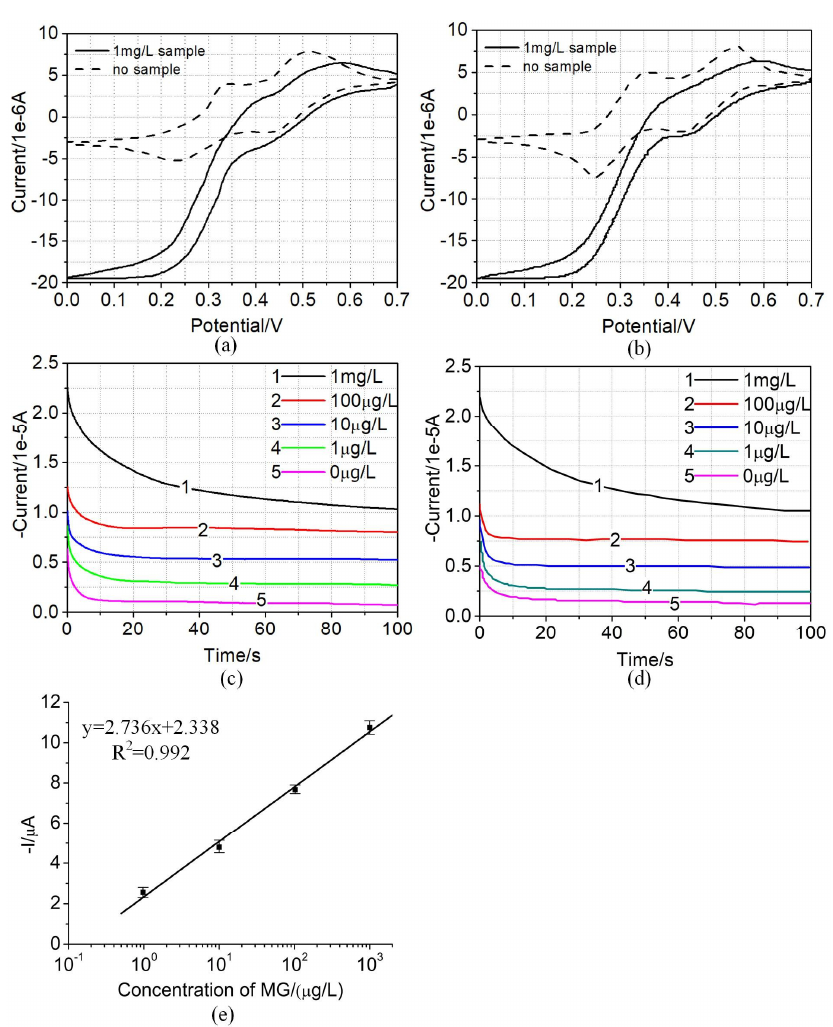
Figure 7. Detection performance of MG. ( a ) Cyclic voltammograms for no target (dashed line) and 1 mg/L target (solid line) obtained from commercial electrochemical instrument. ( b ) Cyclic voltammograms for no target (dashed line) and 1 mg/L target (solid line) obtained from the hand-held electrochemical instrument in this system. ( c ) Amperometric curves of samples with different concentrations (1 mg/L, 100 µ g/L, 10 µ g/L, 1 µ g/L, and 0 µ g/L) in TMB substrate solution obtained from commercial electrochemical instrument. ( d ) Amperometric curves of samples with different concentrations (1 mg/L, 100 µ g/L, 10 µ g/L, 1 µ g/L, and 0 µ g/L) in TMB substrate solution obtained from the hand-held electrochemical instrument in this system. ( e ) A calibration plot of the amperometric current and the log concentration of target. Data were collected from at least three independent experiments.